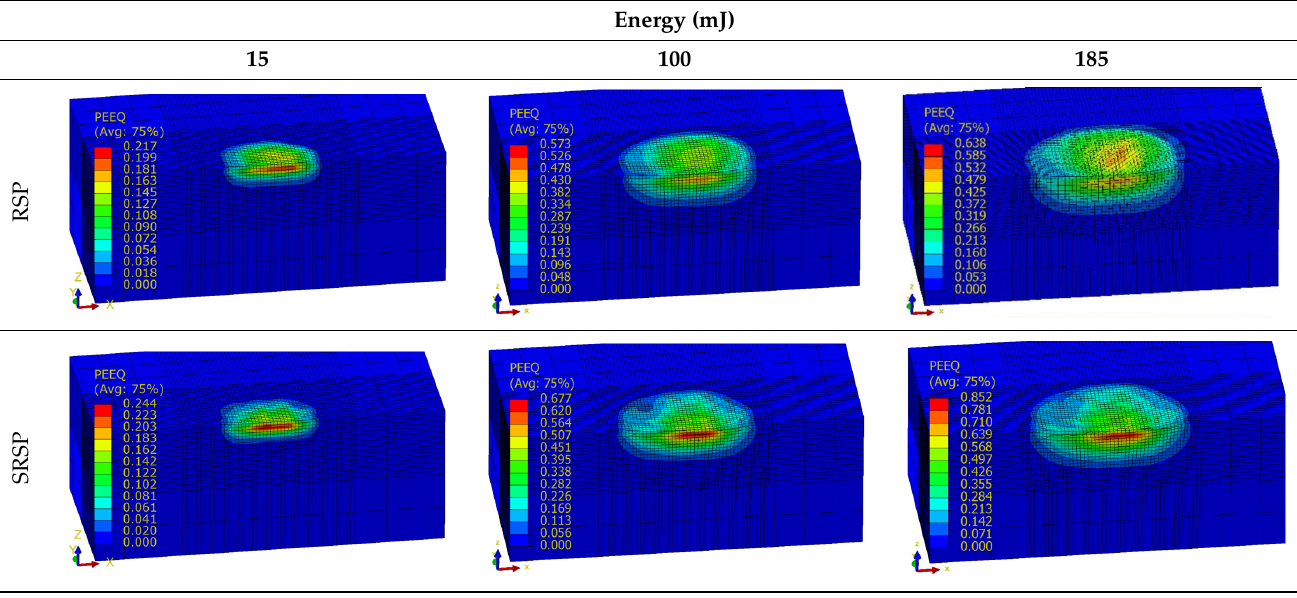
( c ) Figure 17. Comparison of the S11 stress distribution for RSP and SRSP as a function of distance from the surface for dif- ferent distances between the dimples: ( a ) x = 0.15 mm, ( b ) x = 0.3 mm, ( c ) x = 0.6 mm. ( a ) ( c ) Figure 18. Comparison of the S11 stress distribution for RSP and SRSP as a function of distance from the surface for dif- ferent ball diameters: ( a ) D = 3 mm, ( b ) D = 10 mm, ( c ) D = 15 mm. As shown in Figure 19, when the impact energy increases, both the maximum com- pressive stress and the depth of the stress increase.